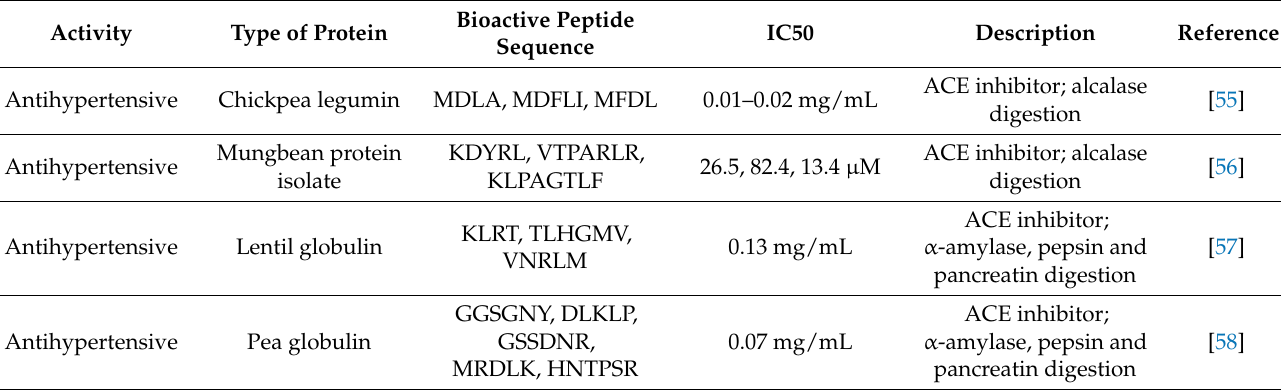
Table 2. Bioactive peptide sequences from some proteins derived from